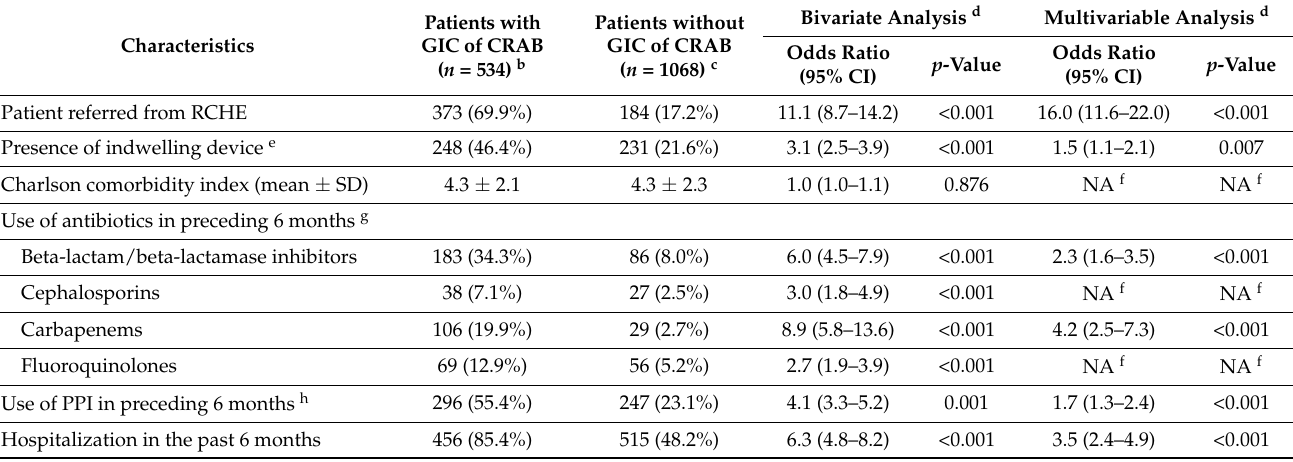
Table 1. Epidemiological characteristics for patients with or without gastrointestinal colonization of carbapenem-resistant A. baumannii (CRAB) in the age- and sex-matched controls a